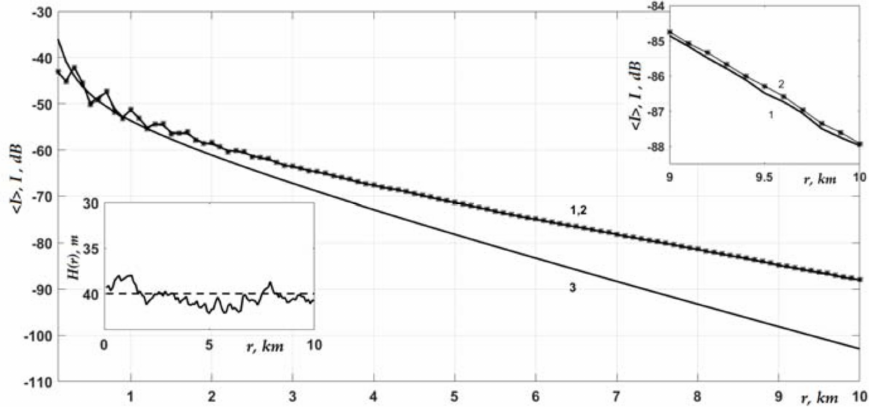
Figure 2. Attenuation of the average intensity of a signal with a frequency of 250 Hz in a waveguide with fluctuations both in the impedance of the bottom δ c 1 and the bathymetry δ h . L rc = L h = 1 km; z = z 0 = 24 m. Curves: 1 is the OW solutions (2) and (3); 2 is the OW solution for δ h = 0 (markers); 3 is intensity averaged over the interference scale for δ c 1 = δ h =